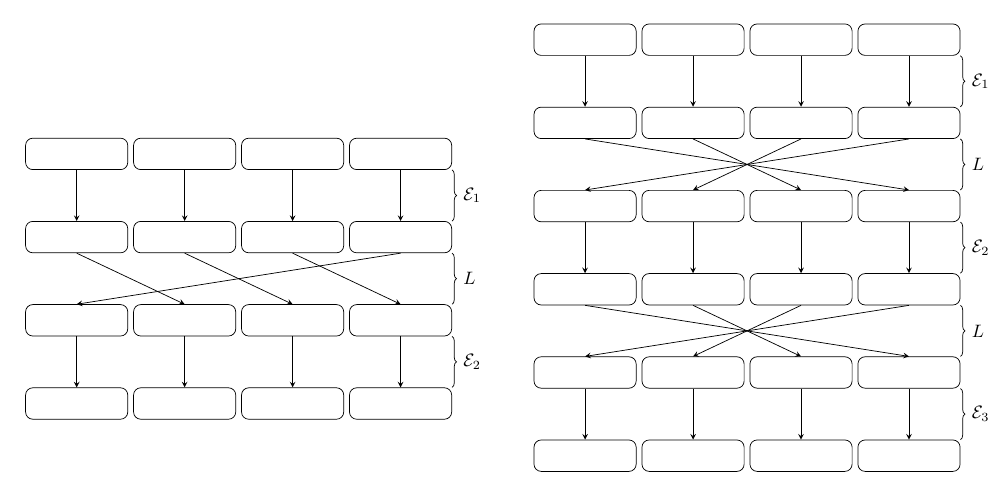
Figure 1: Examples of the construction. On the left is the two layer right shift scheme, and on the right the three layer reversing instantiated with independent